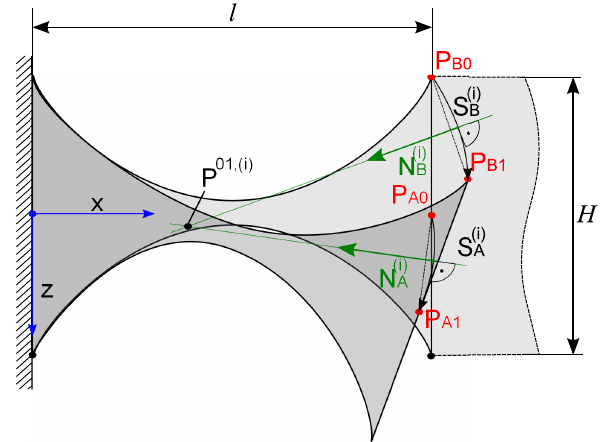
Table 4. Overall center of rotation for rectangular ( R ), circular ( C ) and parabolic ( P ) flexure hinges